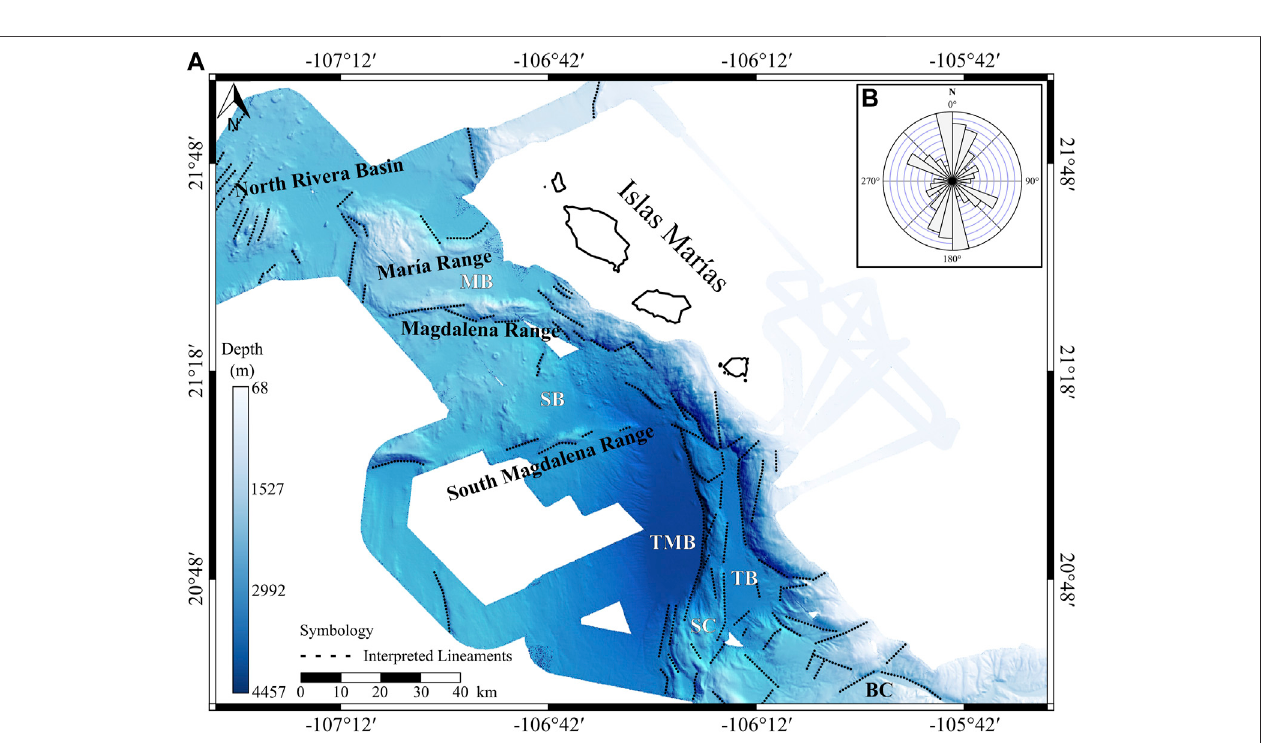
FIGURE 5 | Bathymetry map of the western Islas Marías region. (A) Hypsometric map with interpreted surface lineaments. (B) Bidirectional rose diagram of the structural features interpreted from bathymetry showing a N-S preferential tendency. Black dotted lines represent the interpreted lineaments observed. Data obtained withEM120multibeamechosounderandprocessedwithCARISHipsandSips(v.10.4). Abbreviations : BC ,BanderasCanyon; MB ,Magdalenabasin; SB ,Sisvocbasin; SC , Sierra de Cleofas; TB , TsuJal basin; TMB , Tres Marías basin.